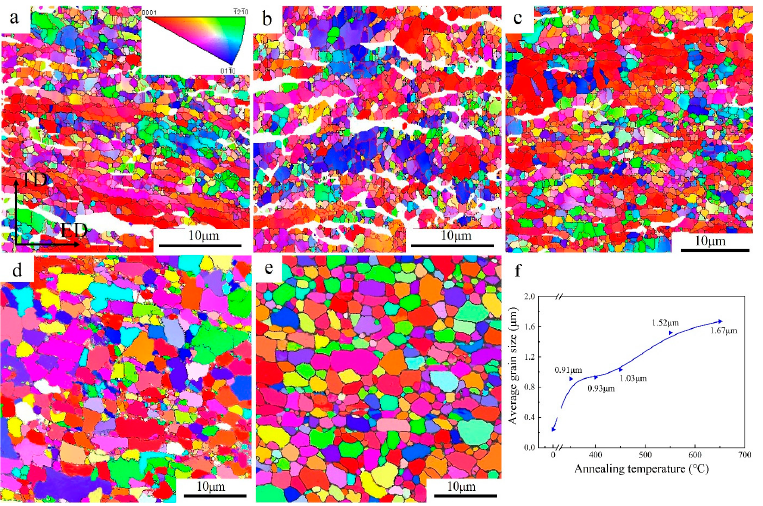
Figure 5. IPF maps and the variation of grain sizes in the UFG TiFeB alloy after annealing at ( a ) 350 °C, ( b ) 400 °C, ( c ) 450 °C, ( d ) 550 °C, and ( e ) 650 °C for 1 h. ( f ) The relationship of grain sizes vs. ( b ) 400 ◦ C, ( c ) 450 ◦ C, ( d ) 550 ◦ C, and ( e ) 650 ◦ C for 1 h. ( f ) The relationship of grain sizes vs. annealing temperatures.